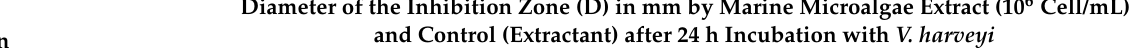
Control Isochrysis sp. ( Extractant